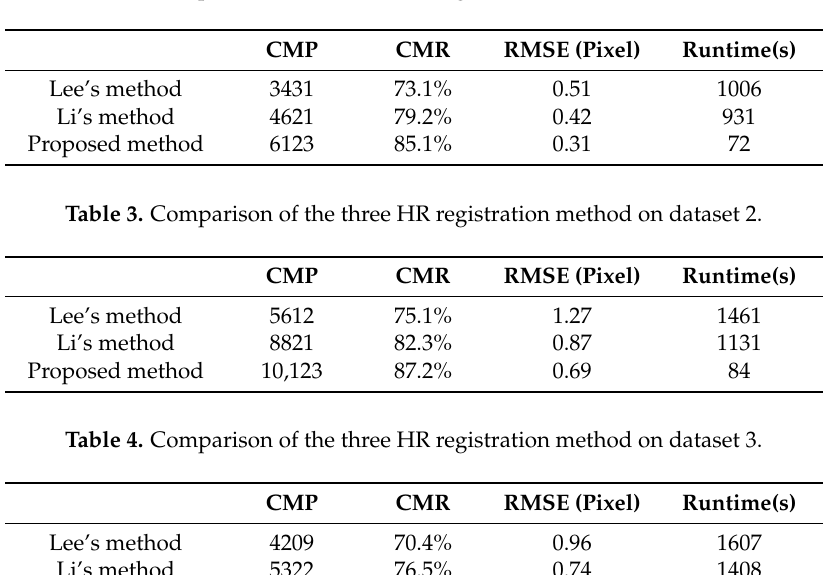
Table 2. Comparison of the three HR registration method on dataset 1.